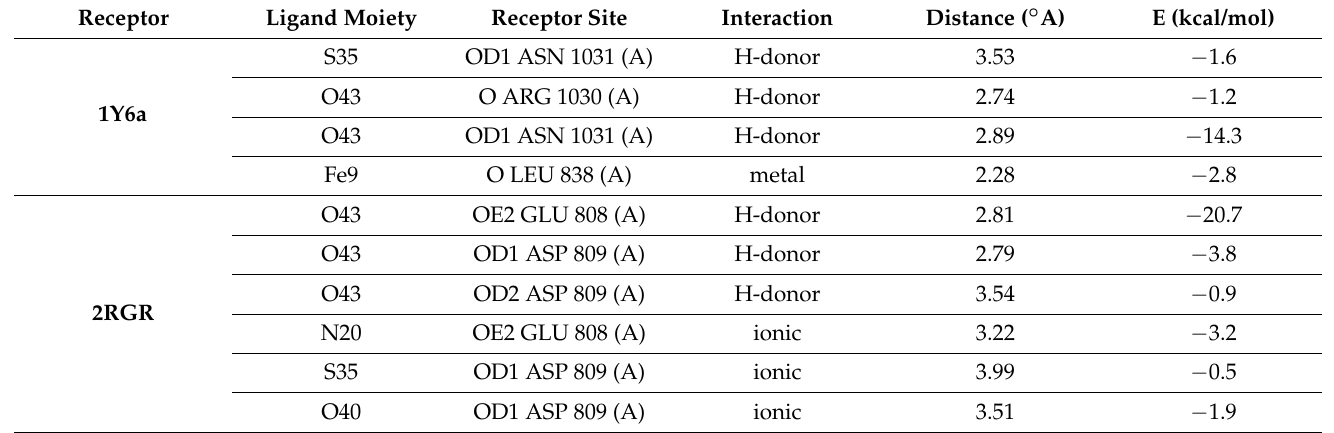
Table 7. Energy values obtained in docking calculations of Cd(II) chelate with crystal structure of (1Y6a), the receptors of (2RGR), crystal structure of Escherichia coli (3T88). Receptor Ligand Moiety Receptor